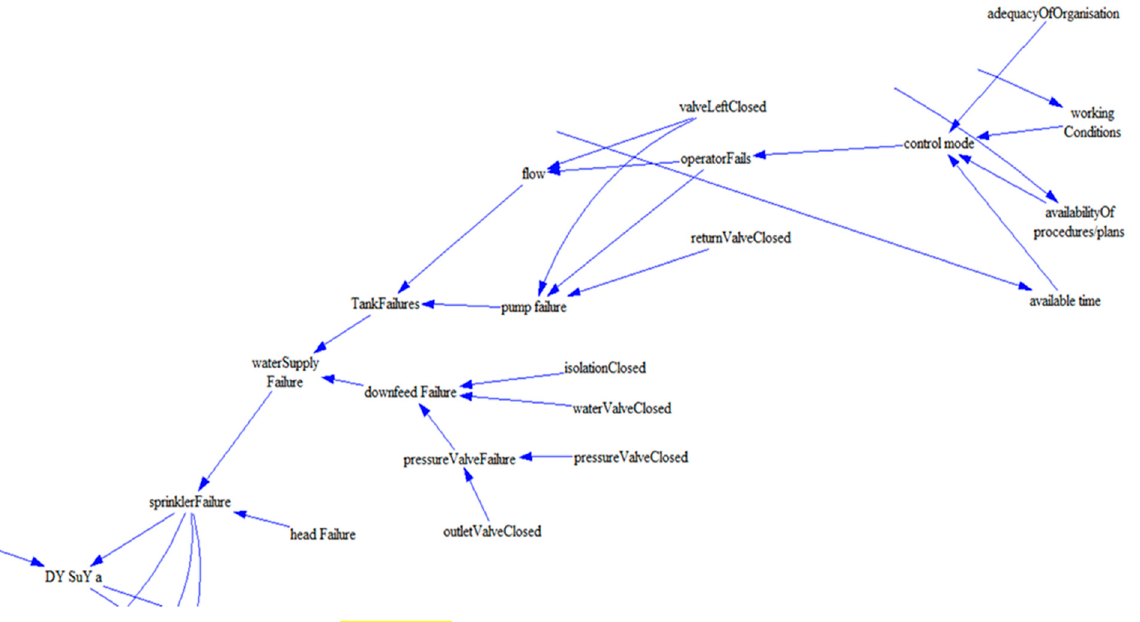
Figure A6. System Dynamics Model extension.